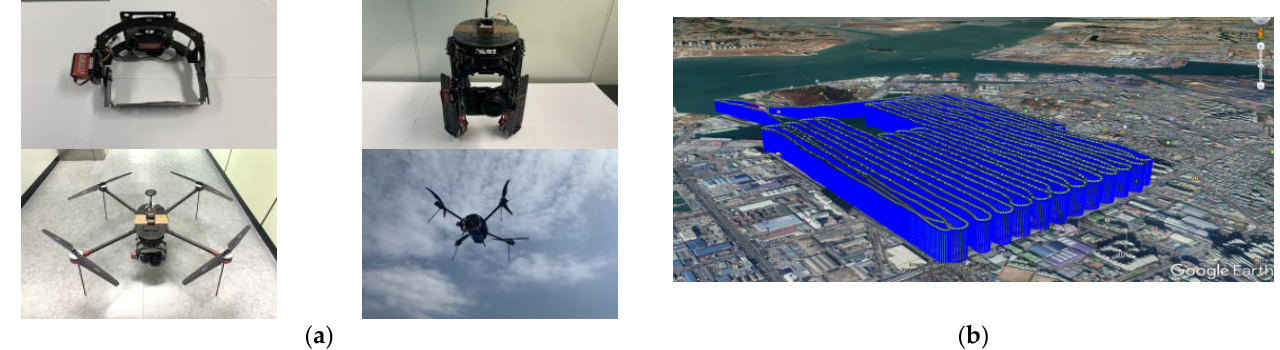
Figure 8. Experimental setup with ( a ) a drone with a front gimbal and its ( b ) flight trajectories at Incheon port.